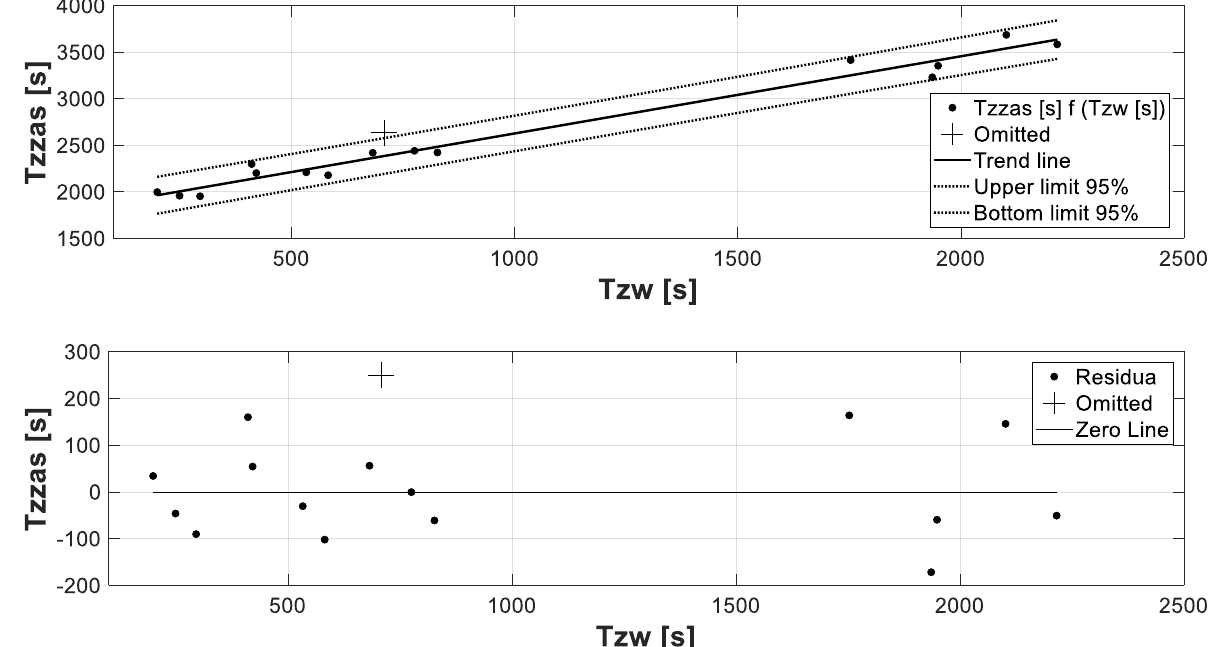
Figure 14. Impact of the circulator pump output on the value of the time constant of the storage tank.